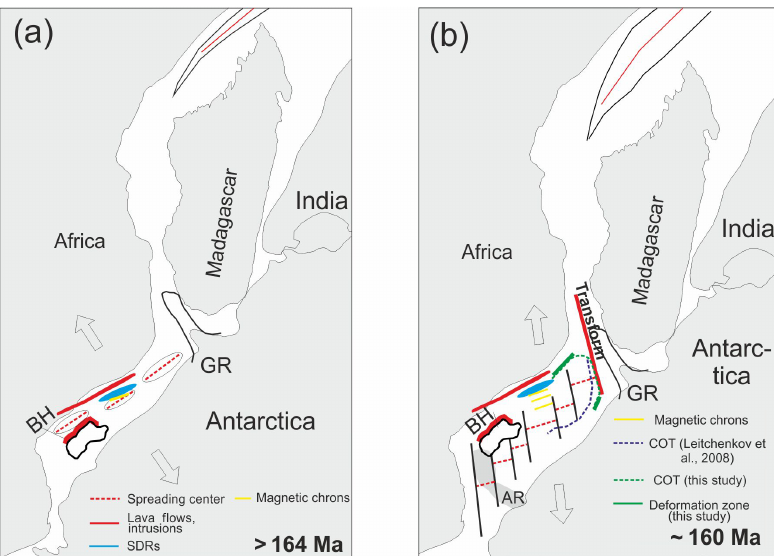
Figure 10. Schematic sketch of the initial opening of the Mozambique Basin and the Riiser-Larsen Sea. (a) In the Middle Jurassic, NW– SE-directed rifting and seafloor spreading between Africa and Antarctica initiates with the possible formation of localized spreading centers close to the present-day shoreline. (b) By the Late Jurassic, the spreading center has jumped to the south and the NW–SE extensional phase has been replaced by N–S-oriented seafloor spreading. At the eastern margin of the evolving Mozambique Basin and the Riiser Larsen Sea basin, a transform deformation phase overprinting the previous continent–ocean transition accommodates the extension. The transform fault develops along the conjugate western flanks of the Davie Ridge and the Gunnerus Ridge. The positions of Madagascar, Antarctica and India have been adopted from Nguyen et al. (2016). Locations of SDRs, lava flows and intrusions in the Mozambique Basin are taken from Mahanjane (2012) and Müller and Jokat (2017). Magnetic chrons taken from Leinweber and Jokat (2012) and Müller and Jokat (2017). The thick green lines mark the basement deformation zone presented in this study. The dashed green line marks the continent–ocean transition (COT) of this study. The dashed purple line is the continent–ocean transition (COT) of Leitchenkov et al. (2008). SW-propagating, NW–SE- oriented oblique rifting and seafloor spreading between Madagascar and Africa according to Klimke and Franke (2016). AR: Astrid Ridge, BH: Beira High, GR: Gunnerus